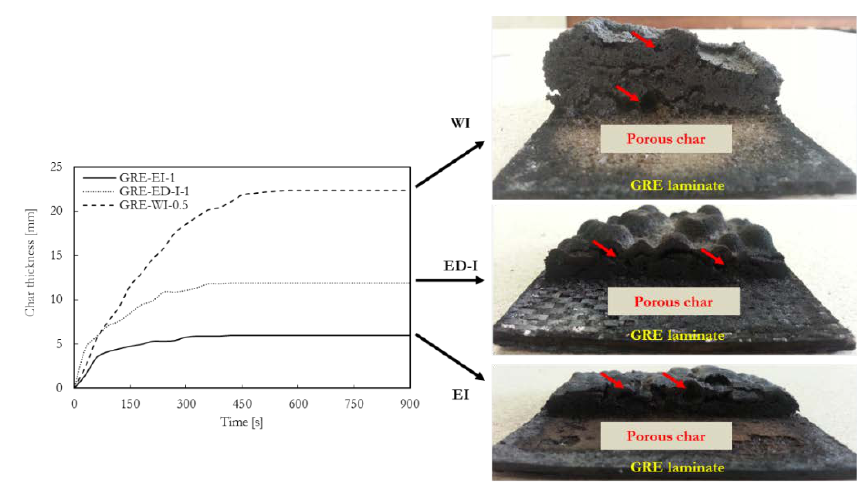
Figure 6. The char expansion vs. time curves and images of residual chars of EI, ED-I and WI intumescent coatings exposed to 50 kW/m 2 incident heat flux for 900s (part of the figure reproduced from [16]). Coatings 2018 , 8 , 347 12 of 18